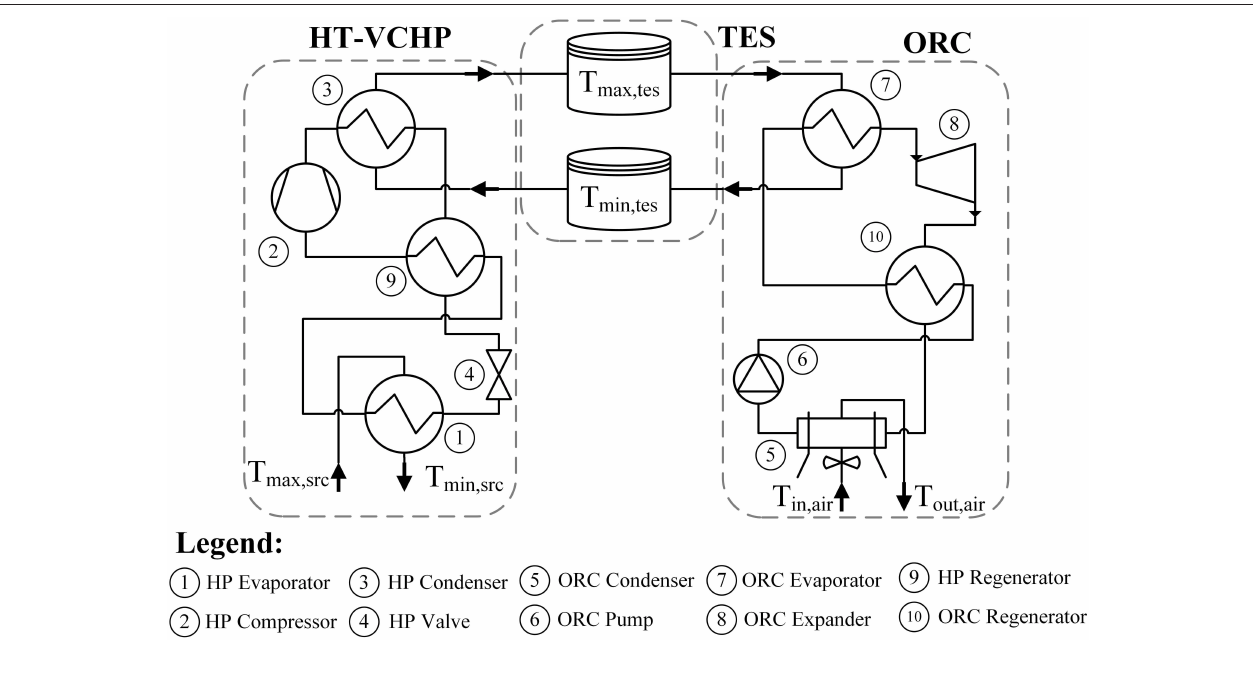
FIGURE 1 | Investigated system layout.